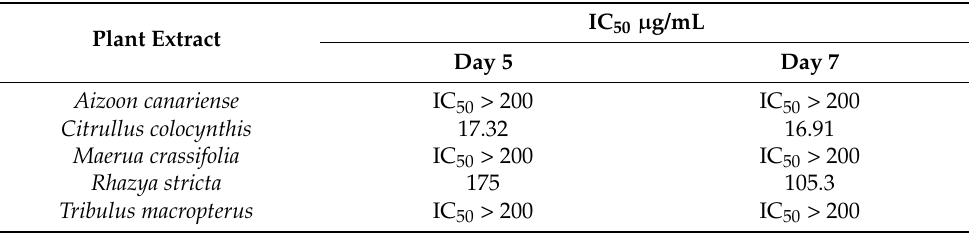
Table 2. The IC 50 of Citrullus colocynthis , Rhazya stricta , Aizoon canariense , Maerua crassifolia , and Tribulus macropterus were determined from the MTT assay after five and seven days of treatment using the line of best fit. The results were obtained through three independent